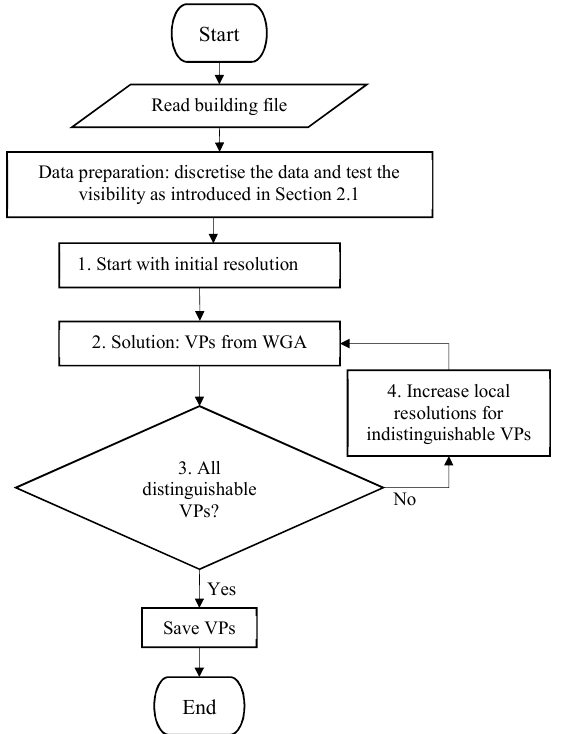
Figure 4. Flowchart of the hierarchical viewpoint planning strategy